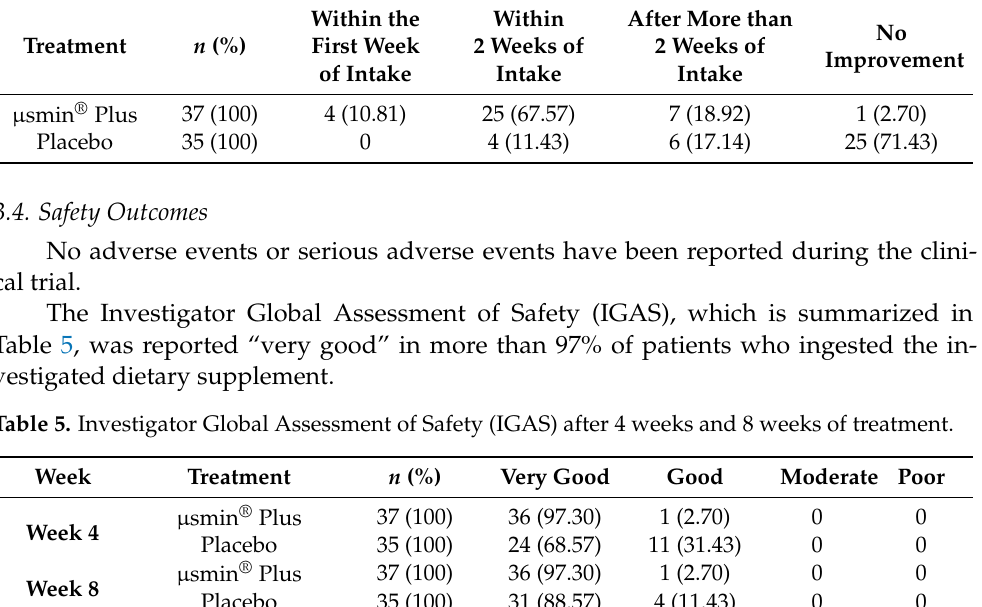
Table 4. Evaluation of symptoms relief.